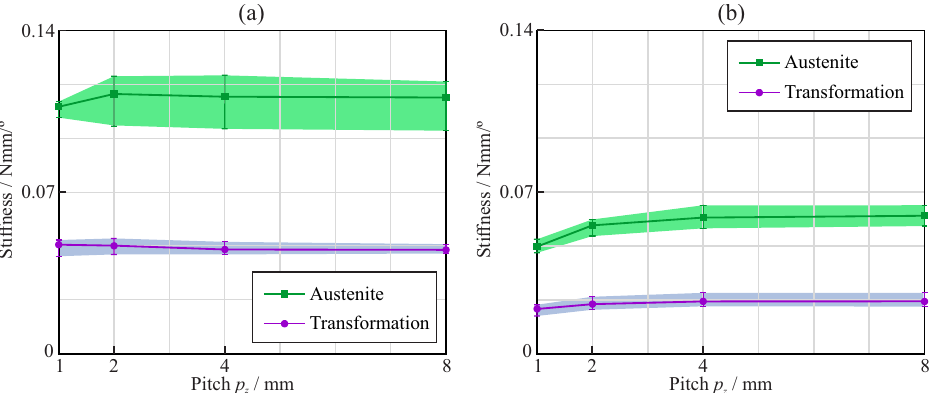
Figure 8. Bending analysis: bending stiffness of the endodontic rotary files with ( a ) square and ( b ) triangular